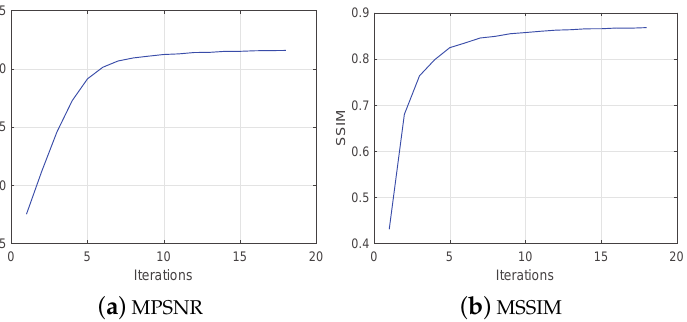
Figure 14. The MPSNR and MSSIM values as a function of iterations in case 2 of the simulated PU